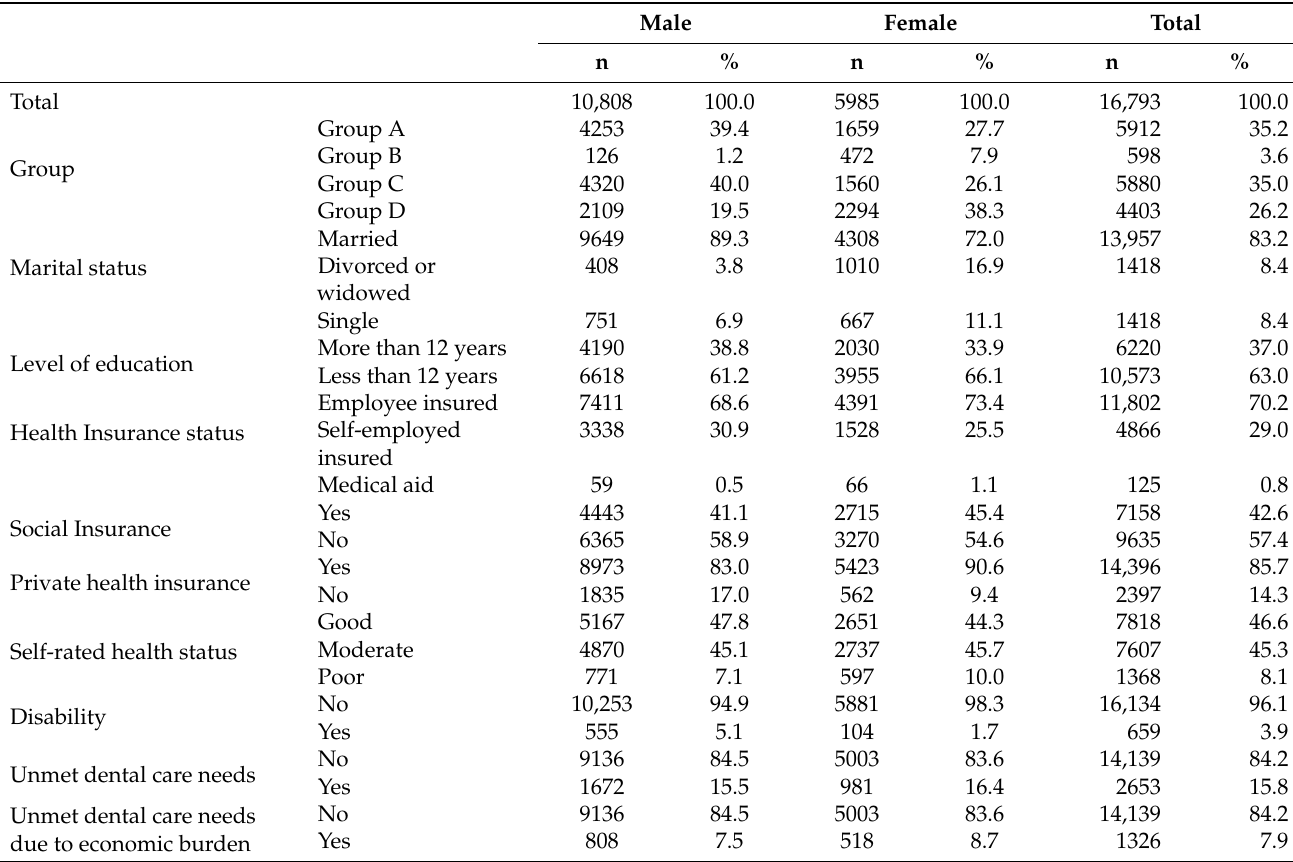
Table 2. General characteristics of the study population from the Korea Health Panel Survey (2011–2017) †